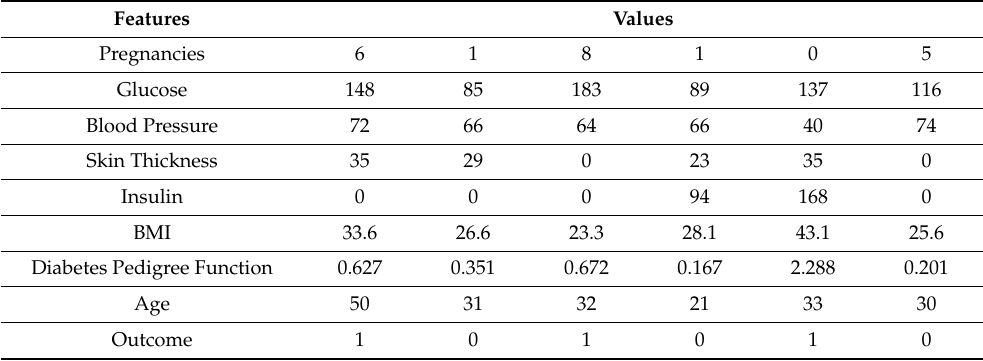
Table 4. Sample of the data points from the PIDD including the features and the